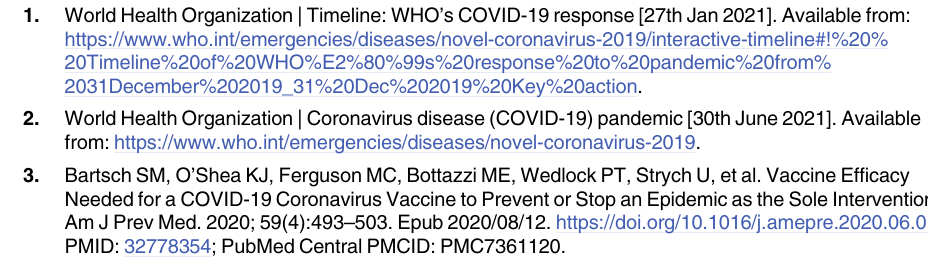
S1 Table. All conditions and results in this study. A-AQ: Actual and estimated number of new cases with confirmed diagnosis and with or without suspected diagnosis of various clinical conditions in Japan from 2015 to 2019 based on data from the MDV and JMDC databases. S2 Table. PICOST (Population, Intervention, Comparator, Outcomes, Study type and Timeframe) table defining inclusion and exclusion criteria for the literature searches. S3 Table. Example search strategy in PubMed for the clinical condition